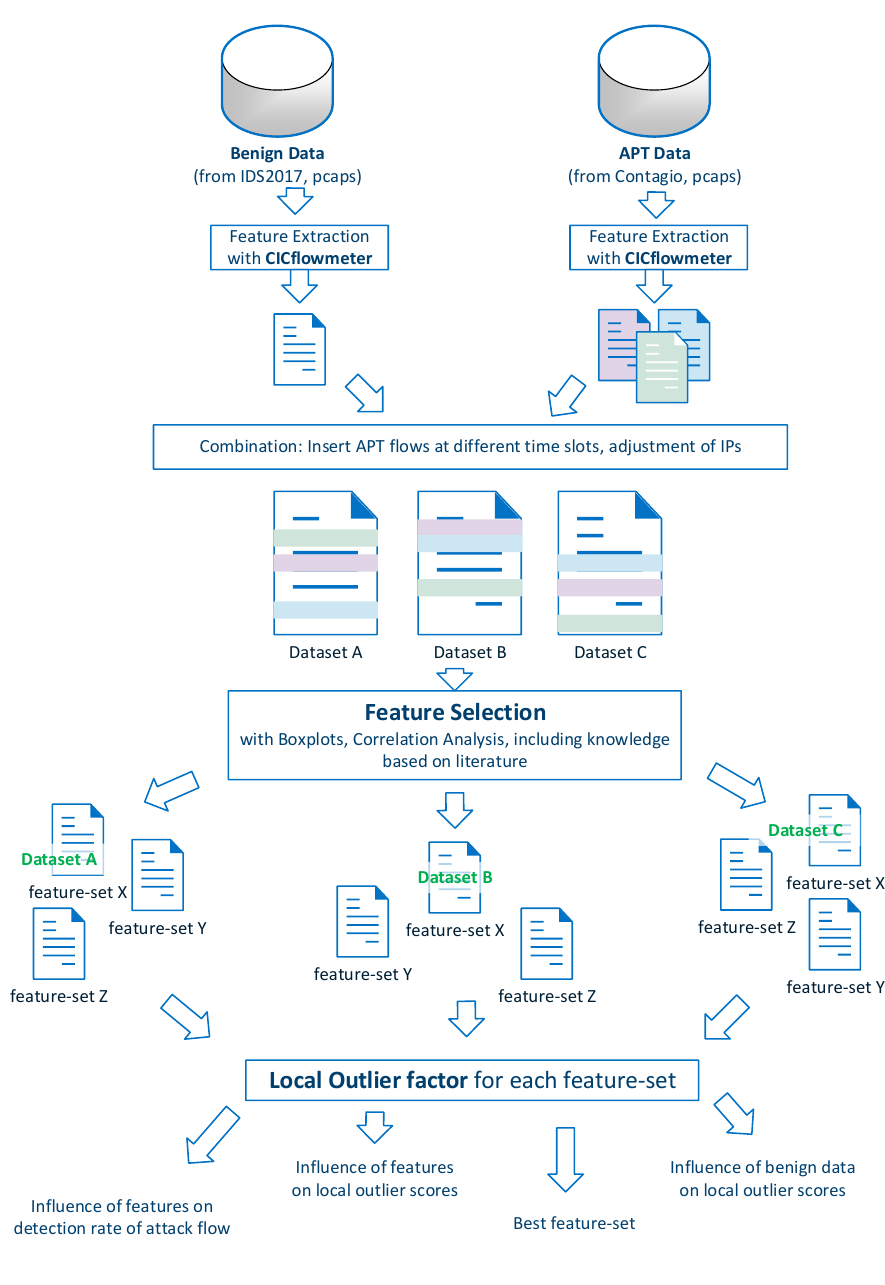
Figure 1. Methodology to investigate the influences of different